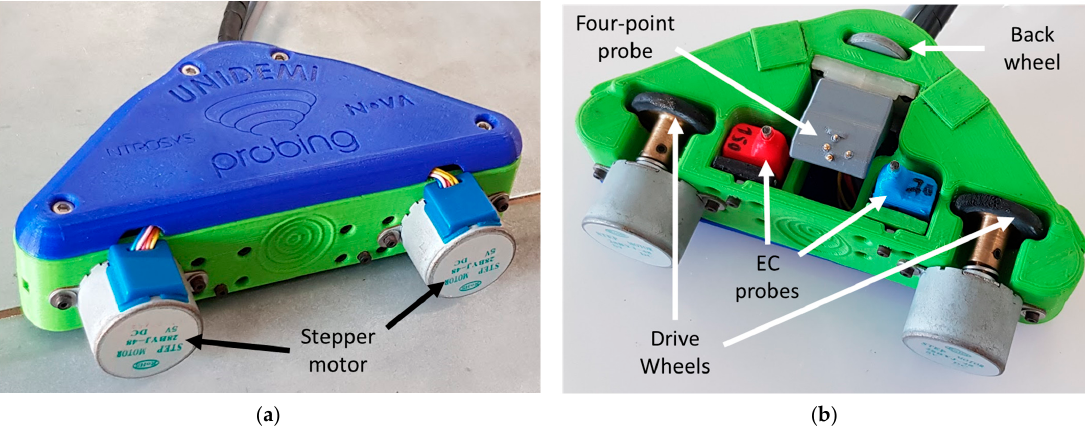
Figure 12. Scanning device comprising both customized eddy currents and four-point probe. ( a ) Top view of the device over a weld specimen; ( b ) bottom view.